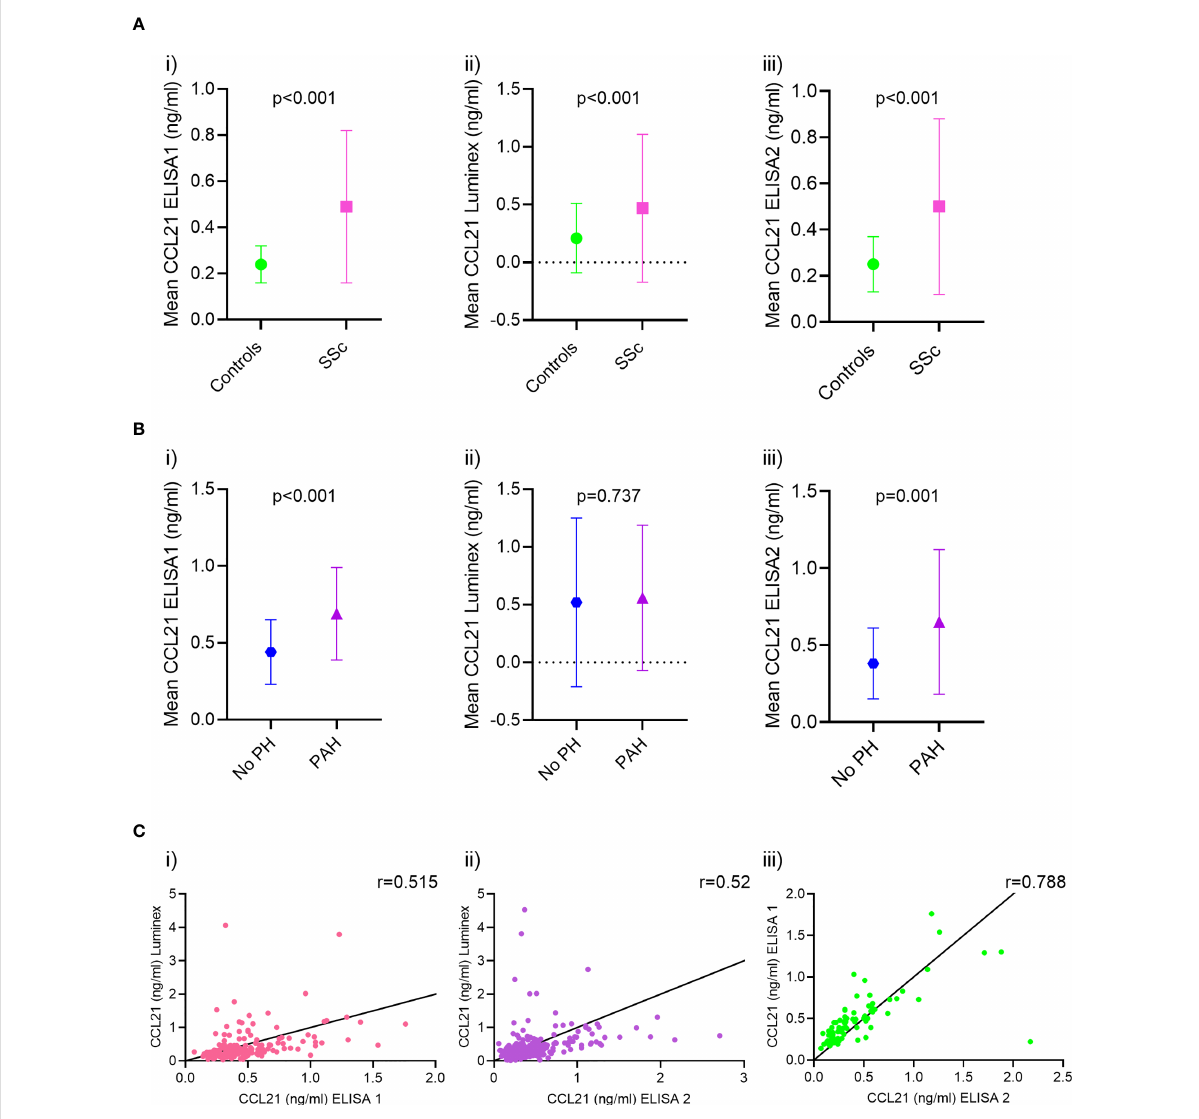
FIGURE 4 CCL21 serum levels and correlation analysis in ELISA 1, Luminex and ELISA 2. (A) The mean serum levels of CCL21 in ELISA 1 were higher in SSc patients compared to healthy controls (i) in Luminex (ii) and ELISA 2 (iii). (B) In ELISA 1, CCL21 serum levels were higher in patients diagnosed with PAH compared to patients with no PH (i) while similar in PAH patient and no PH (ii) in Luminex. The mean serum levels of CCL21 in ELISA 2 however were, like in ELISA 1, higher in PAH patients compared to those without PH (iii). (C) The correlation of CCL21 serum levels between ELISA 1 and Luminex (r=0.515, p<0.001) (i) and the correlation of CCL21 serum levels between ELISA 2 and Luminex (r=0.52, p<0.001) (ii) were poor. However, the correlation of CCL21 serum levels between ELISA 2 and ELISA 1 (r=0.788, p<0.001) (iii) were